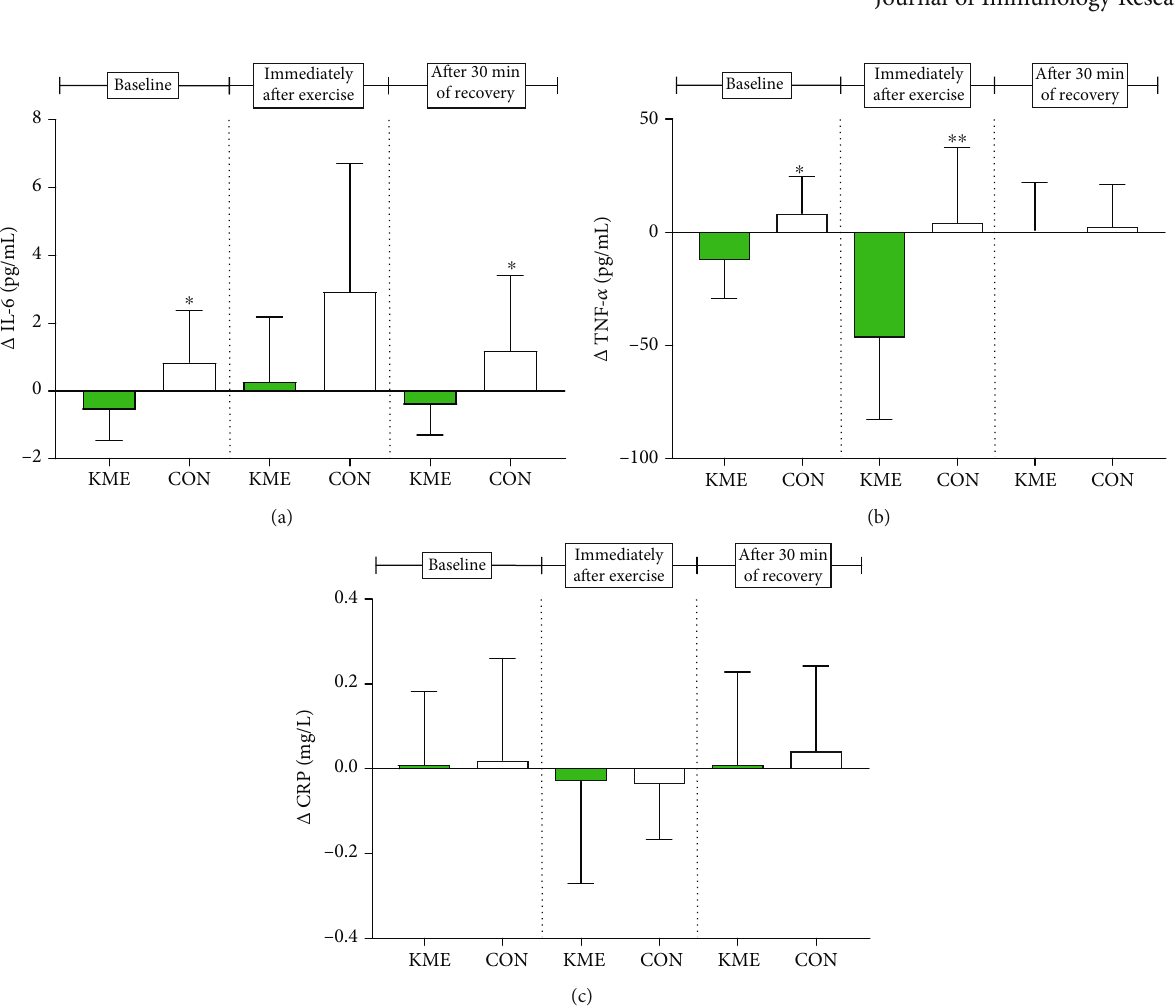
Figure 4: Change in in fl ammation biomarkers. (a) Signi fi cant di ff erences were observed at baseline and after 30 min of recovery in the delta ( Δ ) values of IL-6 ( ∗ p < 0 : 05 , ∗ p < 0 : 05 ). (b) Signi fi cant di ff erences were observed at baseline and immediately after exercise in the delta ( Δ ) values of TNF- α ( ∗ p < 0 : 05 , ∗∗ p < 0 : 01 ). (c) Δ values of CRP, no signi fi cant di ff erences were observed. Data are shown as means ± SD